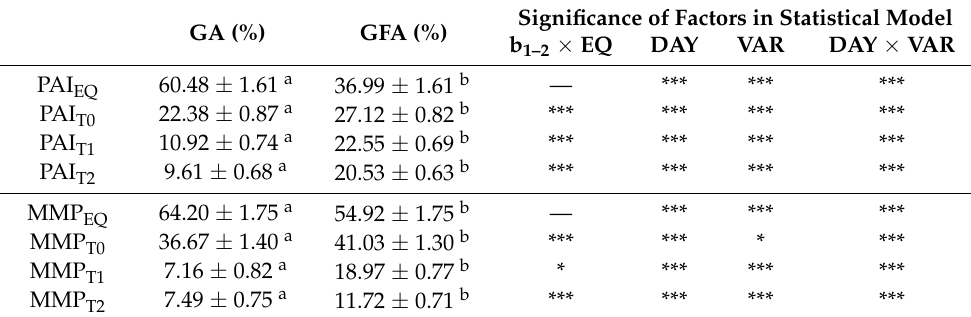
Table 2. Significance of factors used in statistical models for flow cytometric